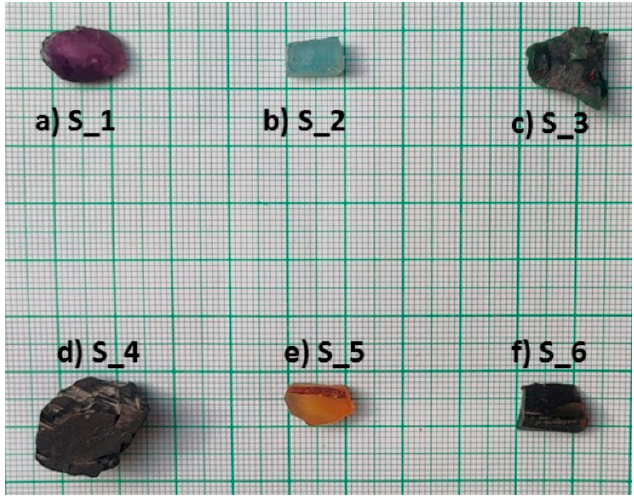
Figure 1. The gemstones analyzed during the present study are shown here. ( a ) Amethyst (S_1),